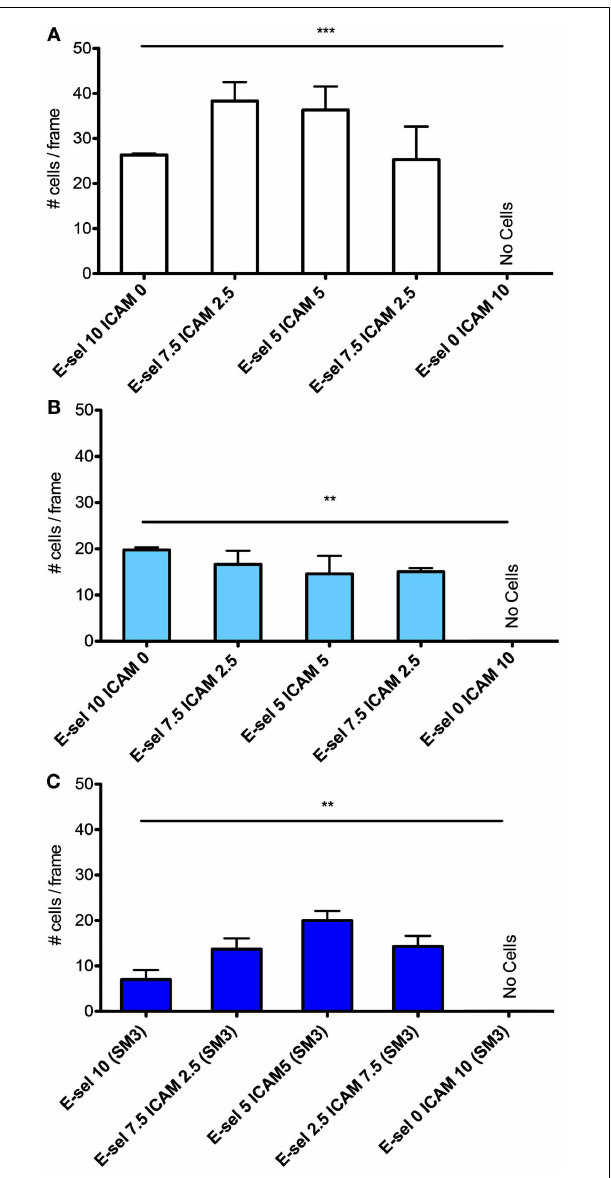
FIGURE 4 | Quantification of average number of cells captured on the surfaces with varying ratios of E-selectin and ICAM-1 for (A) ZR-75-1, (B) MCF7, and (C) SM3 blocked ZR-75-1 cells. One-way ANOVA was used for statistical analysis. For all three experiments, results from all conditions were found to be significantly different with p -values of 0.0008, 0.0093, and 0.0016 for ZR-75-1, MCF7, and SM3 blocked ZR-75-1, respectively. ** p ≤ 0.01; *** p ≤